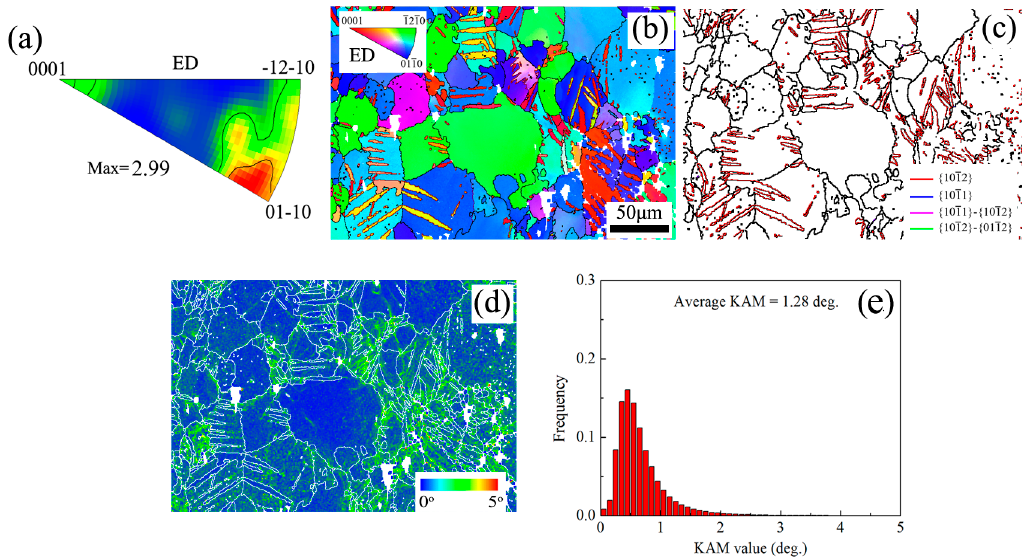
Figure 9. Microstructure characteristics in edge position of STA sample: ( a ) inverse pole figure ( b ) IPF map; ( c ) GB + TB map; ( d ) KAM map and ( e ) KAM distribution figure.